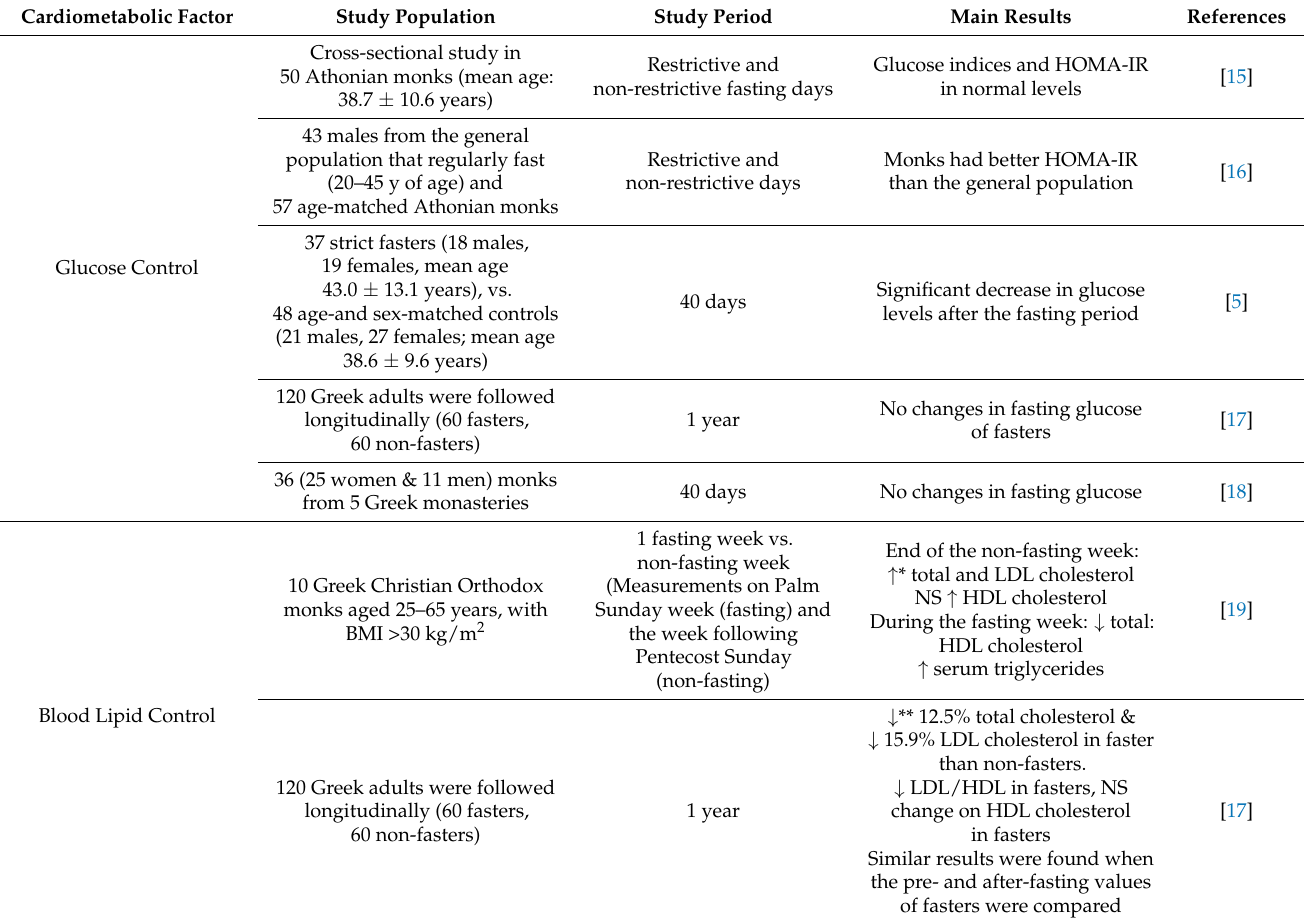
Table 1. Studies concerning the impact of Christian Orthodox fasting on cardiometabolic factors. Cardiometabolic